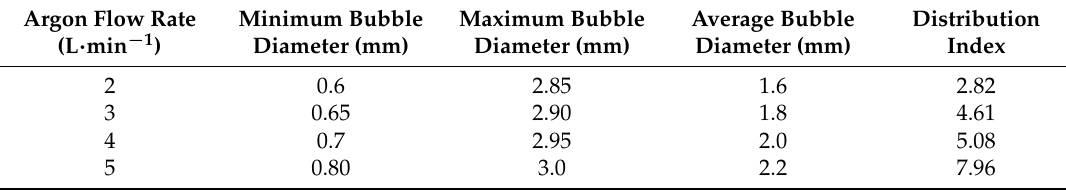
Table 3. Parameters of Rosin–Rammler distribution used in calculation.